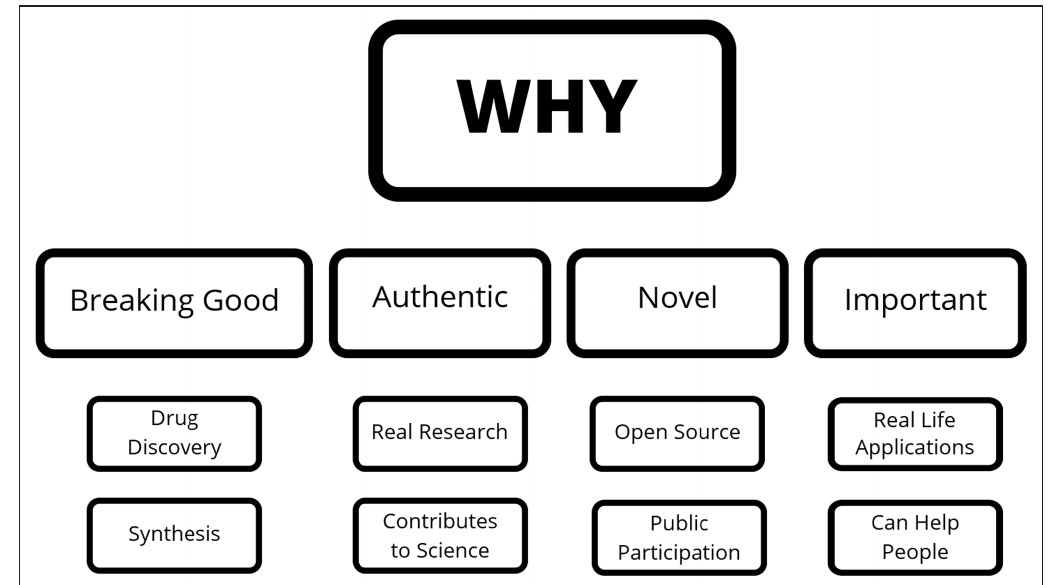
Figure 3 The unique project